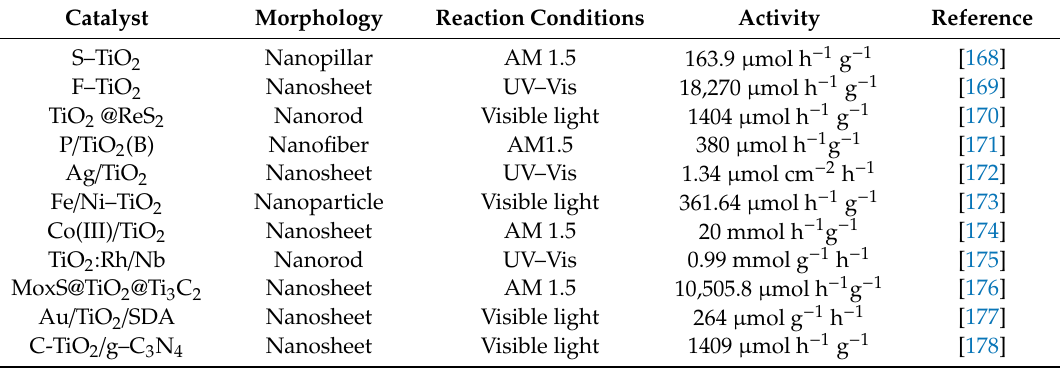
Table 1. Summary of common methods to improve the photocatalytic hydrogen production activity of TiO 2